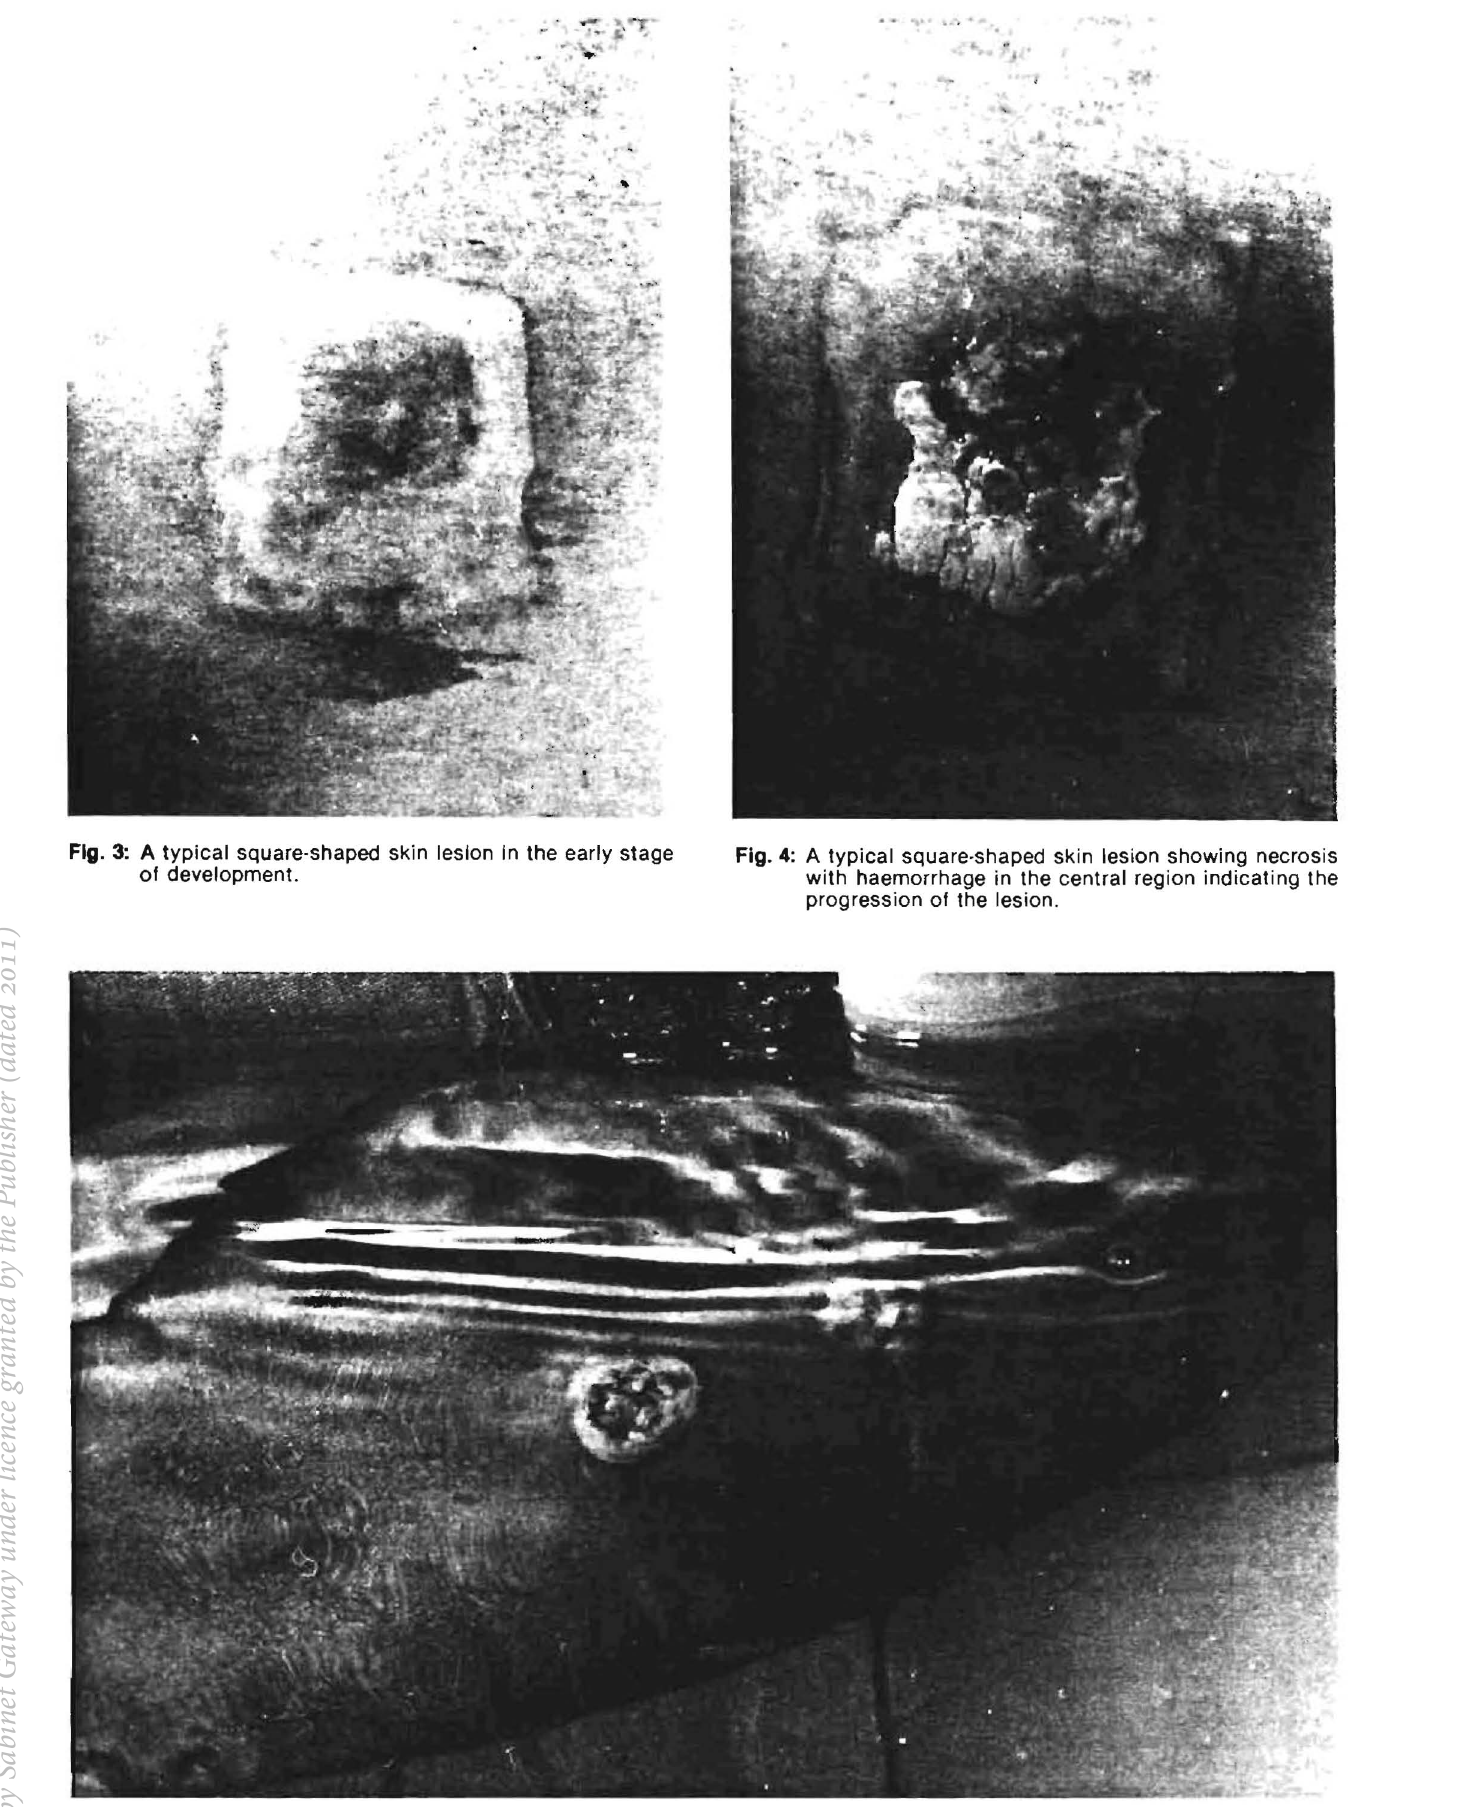
Fig. 3: A typical square·shaped skin lesion In the early stage of development.